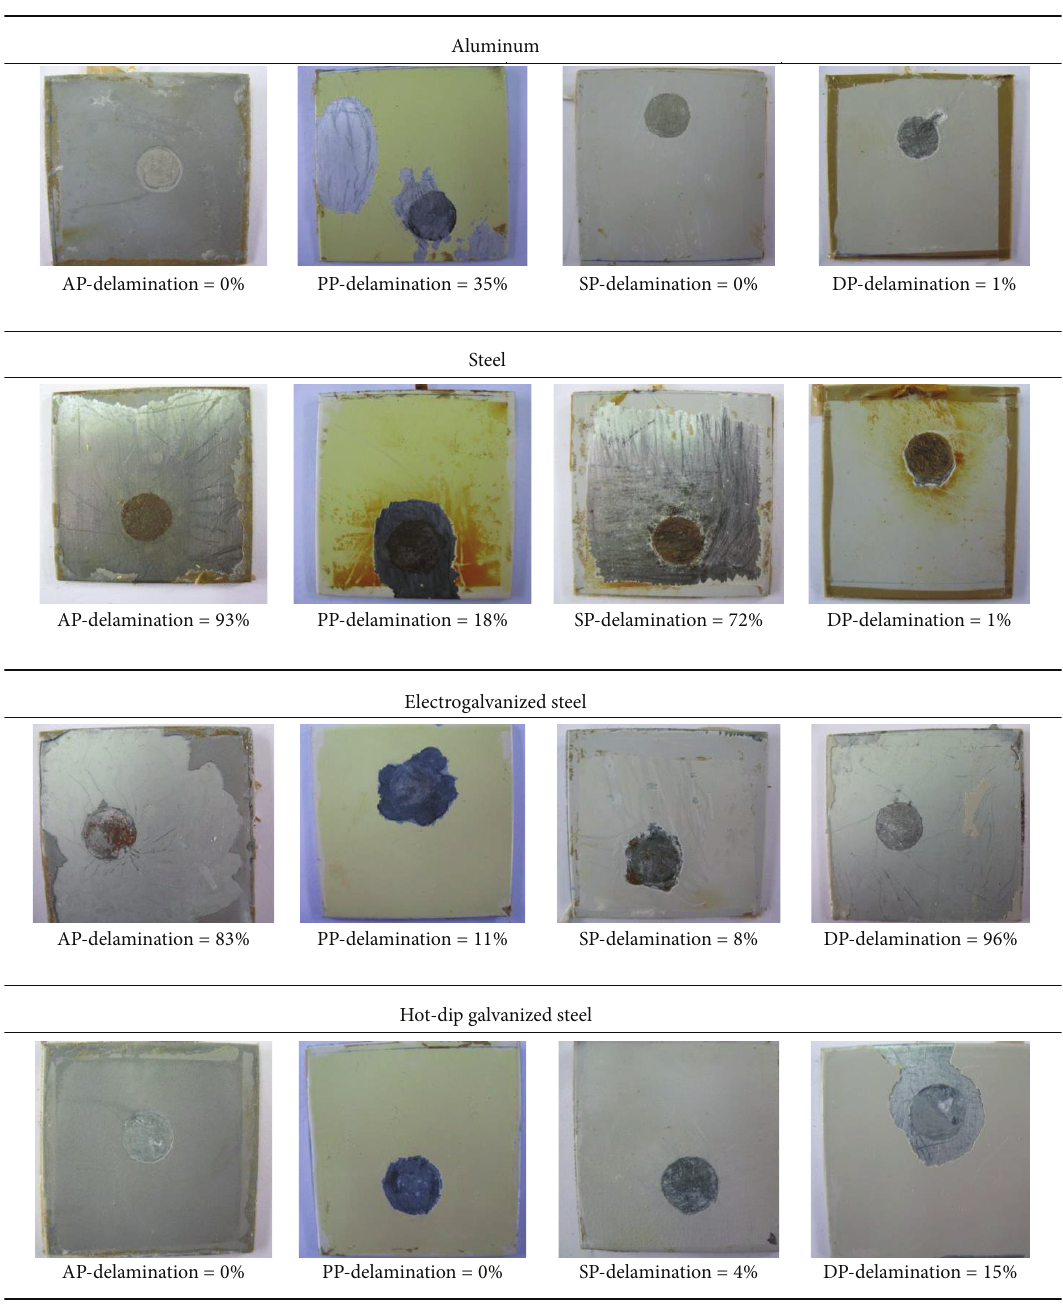
Figure 4: Delamination of primers applied on the different substrates after 15 days of exposure in 5% NaCl solution.